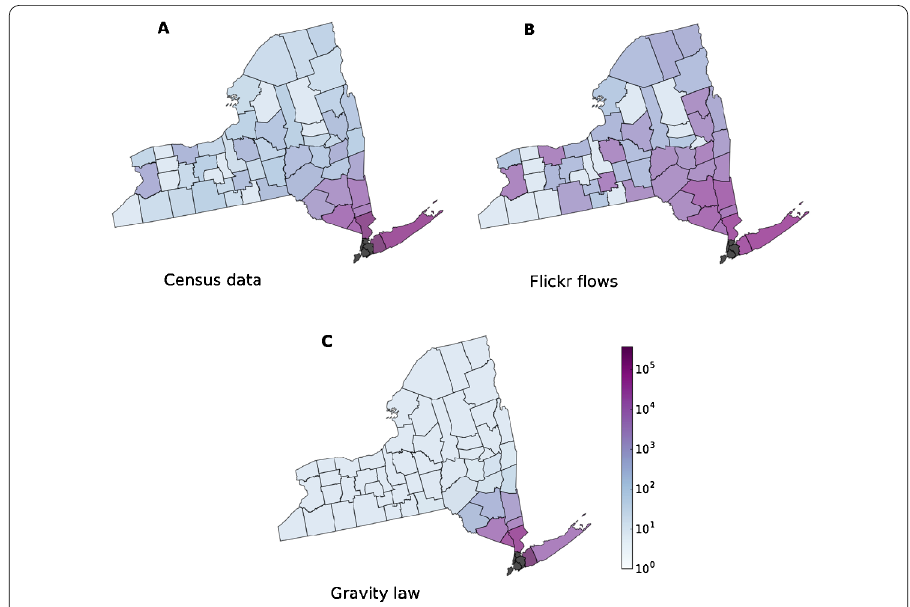
Figure 2 Daily commuting to New York City. The color scale represents the daily number of commuters arriving to New York City from the different counties of the New York State. The 5 boroughs of New York City are aggregated and represented in black. (A) : US Census Bureau data. (B) : Flickr traces. (C) : Gravity law. No maximum distance threshold was considered in this figure for the Flickr traces. Visualization created with matplotlib [44].